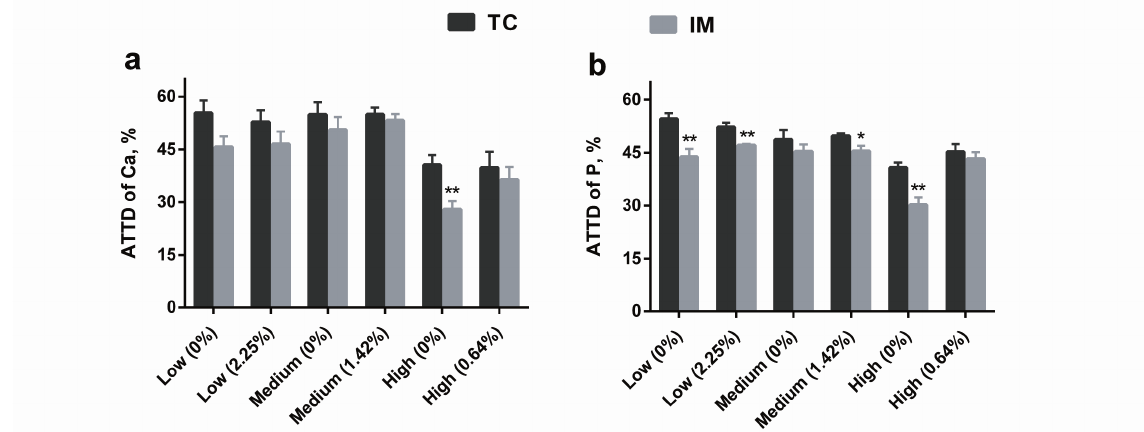
Figure 1. Comparison of apparent total tract digestibility (ATTD) of Ca and P in diets between total collection (TC) method and indicator method (IM). (a) The ATTD of Ca; (b) The ATTD of P. Values are means with their standard errors (** Significant difference between collection methods, p<0.01; * Significant difference between collection methods, p<0.05; n = 6). Low (0%), low Ca diet without maifanite supplementation; Low (2.25%), low Ca diet with maifanite supplementation; Medium (0%), medium Ca diet without maifanite supplementation; Medium (1.42%), medium Ca diet with maifanite supplementation; High (0%), high Ca diet without maifanite supplementation; High (0.64%), high Ca diet with maifanite